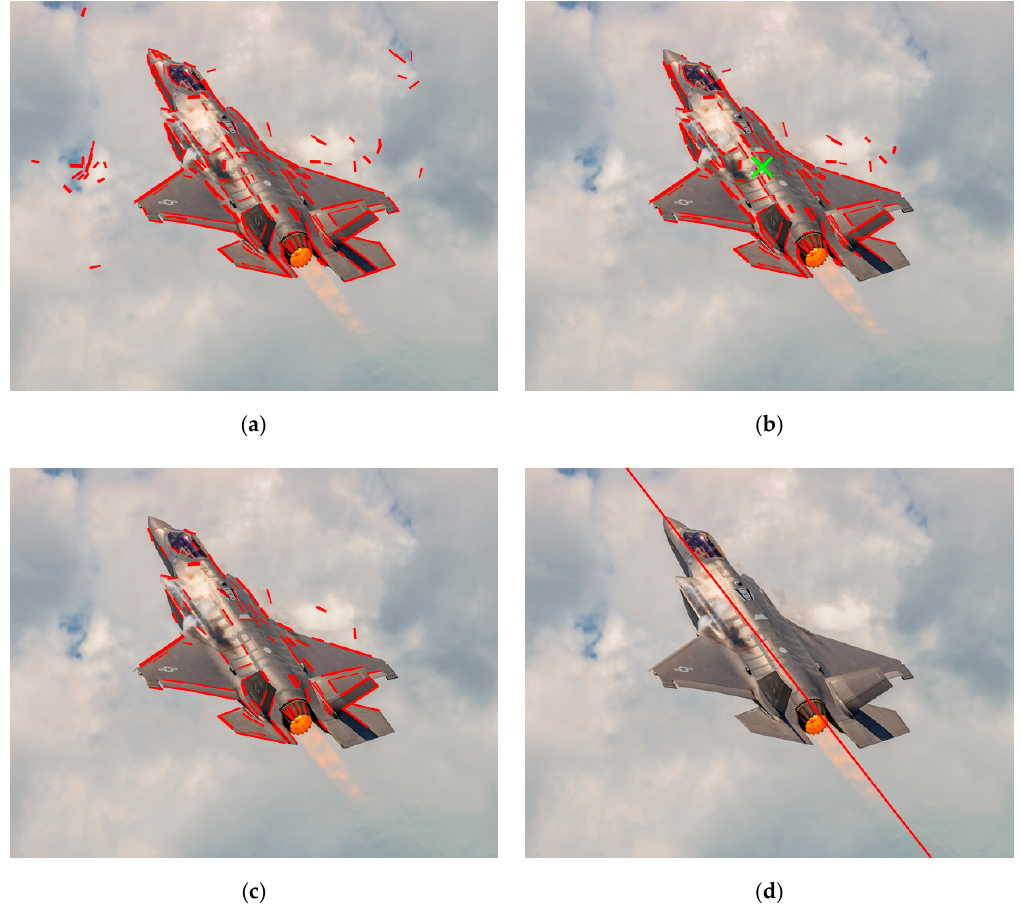
Figure 3. The results of line feature detection and fuselage extraction based on spatial, length and orientation consistency constraints: ( a ) line feature detection; ( b ) line clustering based on spatial consistency constraint; ( c ) length consistency constraint; ( d ) extraction of fuselage reference line based on parallel line clustering.